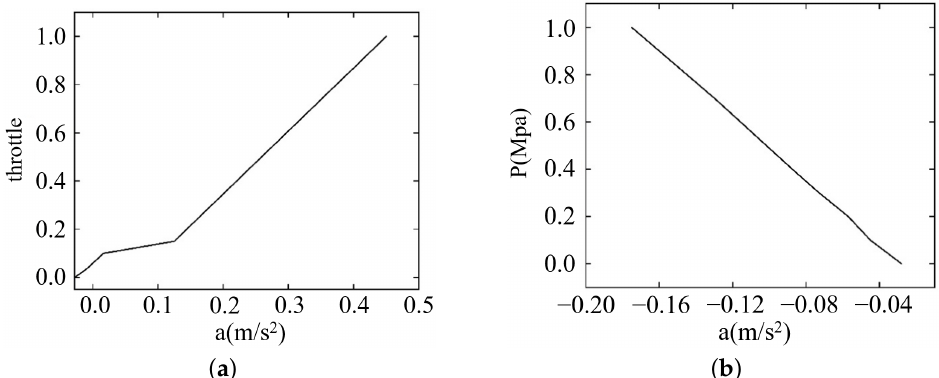
Figure 10. Calibration scale. ( a ) Throttle percentage. ( b ) Brake